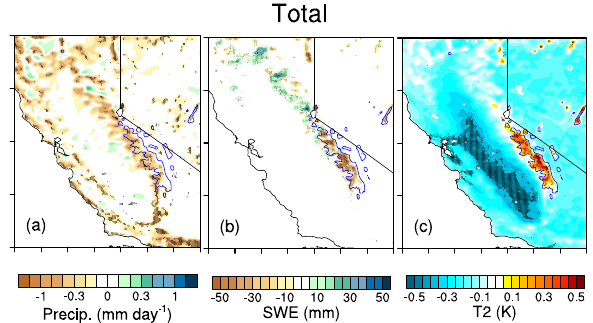
Figure 6. ARI effects (CTRL – NARI) on spatial distributions of (a) precipitation (mmday − 1 ) , (b) SWE (mm), and (c) T2 (K). Blue lines represent the mountaintops with elevation ≥ 2.5km.